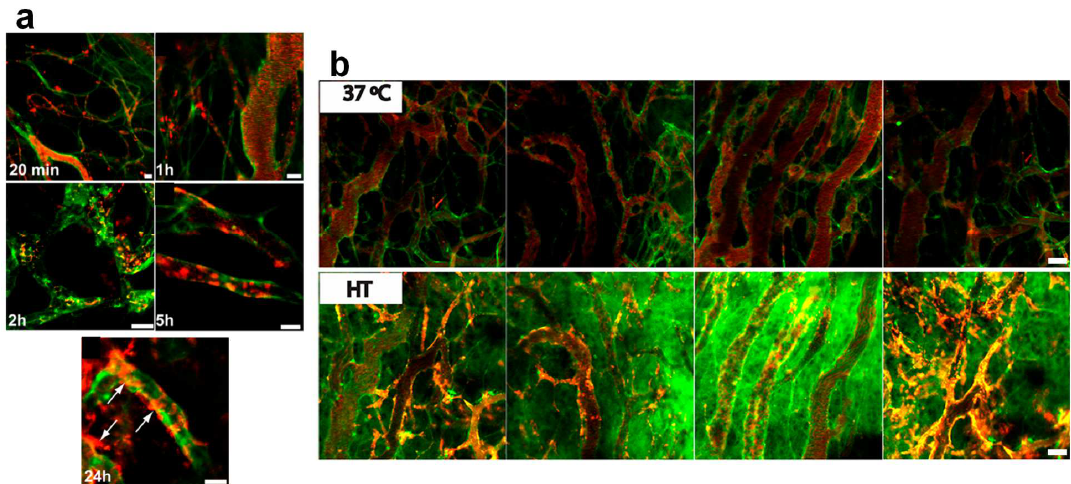
Figure 8. Intravital evaluation of the binding and temperature triggered release of CTSL. Panel ( a ) represents the binding of Rho-PE-labeled (red) CTSL to tumor endothelial cells (green). Appearance of vasculature-bound cationic liposomes started 20 min after injection and remained visible for at least 24 h. CTSL were found to be associated with the tumor vasculature or extravasated perivascularly (white arrows). Scale bar for all images indicates 20 µ m. Panel ( b ) illustrates the release of carboxyfluorescein (CF) from CTSL upon application of HT. Images of circulating liposomes in bloodstream at 37 ◦ C were taken 2 h after injection. Then, the tumor was heated up to 43 ◦ C for 1 h, and representative images from different positions in the tumor area were recorded at the end of the HT treatment. Scale bar in all images, 50 µ m. In both studies, C57 mice bearing B16BL6 tumor models, using a dorsal skin-fold chamber, received a single IV dose of 5 µ mol liposomal lipid. Reprinted with permission from [31] Copyright 2013, American Chemical